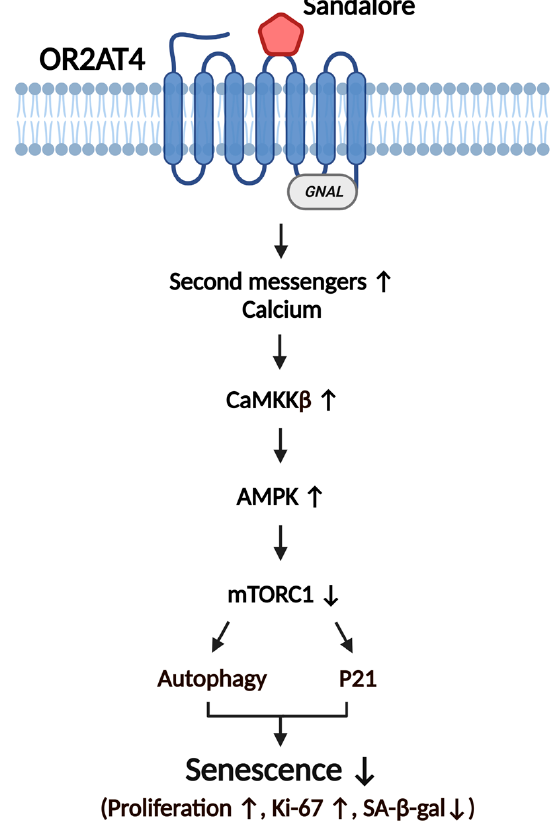
Figure 6. Proposed role of OR2AT4 in the suppression of senescence in human keratinocytes. Sandalore binds and activates OR2AT4 to increase the levels of second messengers, mainly intracellular calcium. The increased intracellular calcium level activates the CAMKK β /AMPK/mTORC1/autophagy signaling axis. OR2AT4 inhibits p21, a marker of cellular senescence, by activating AMPK phosphorylation. Overall, OR2AT4 activation by sandalore may improve cellular senescence in human keratinocytes.